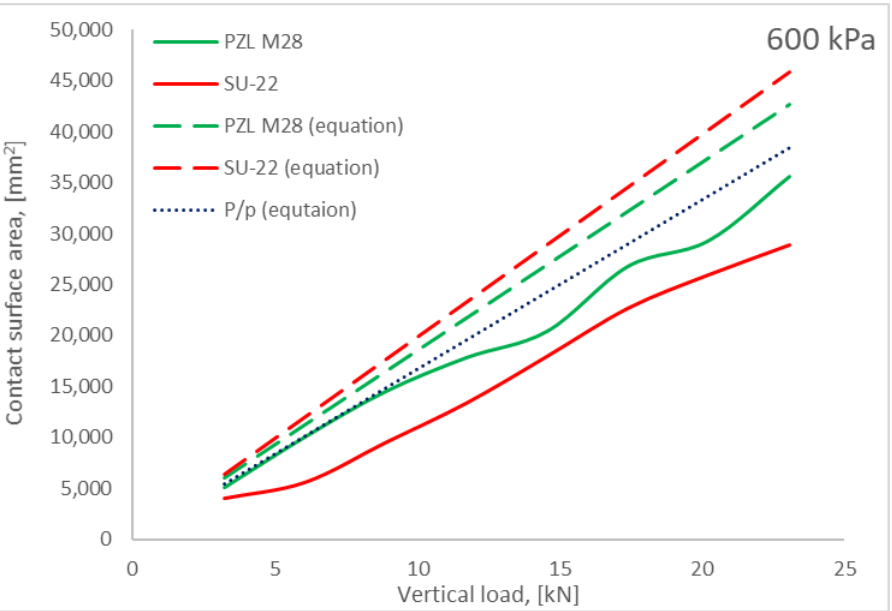
Figure 16. Contact surface area of the aircraft tire with the surface, in relation to the load for the wheel pressure of 600 kPa.